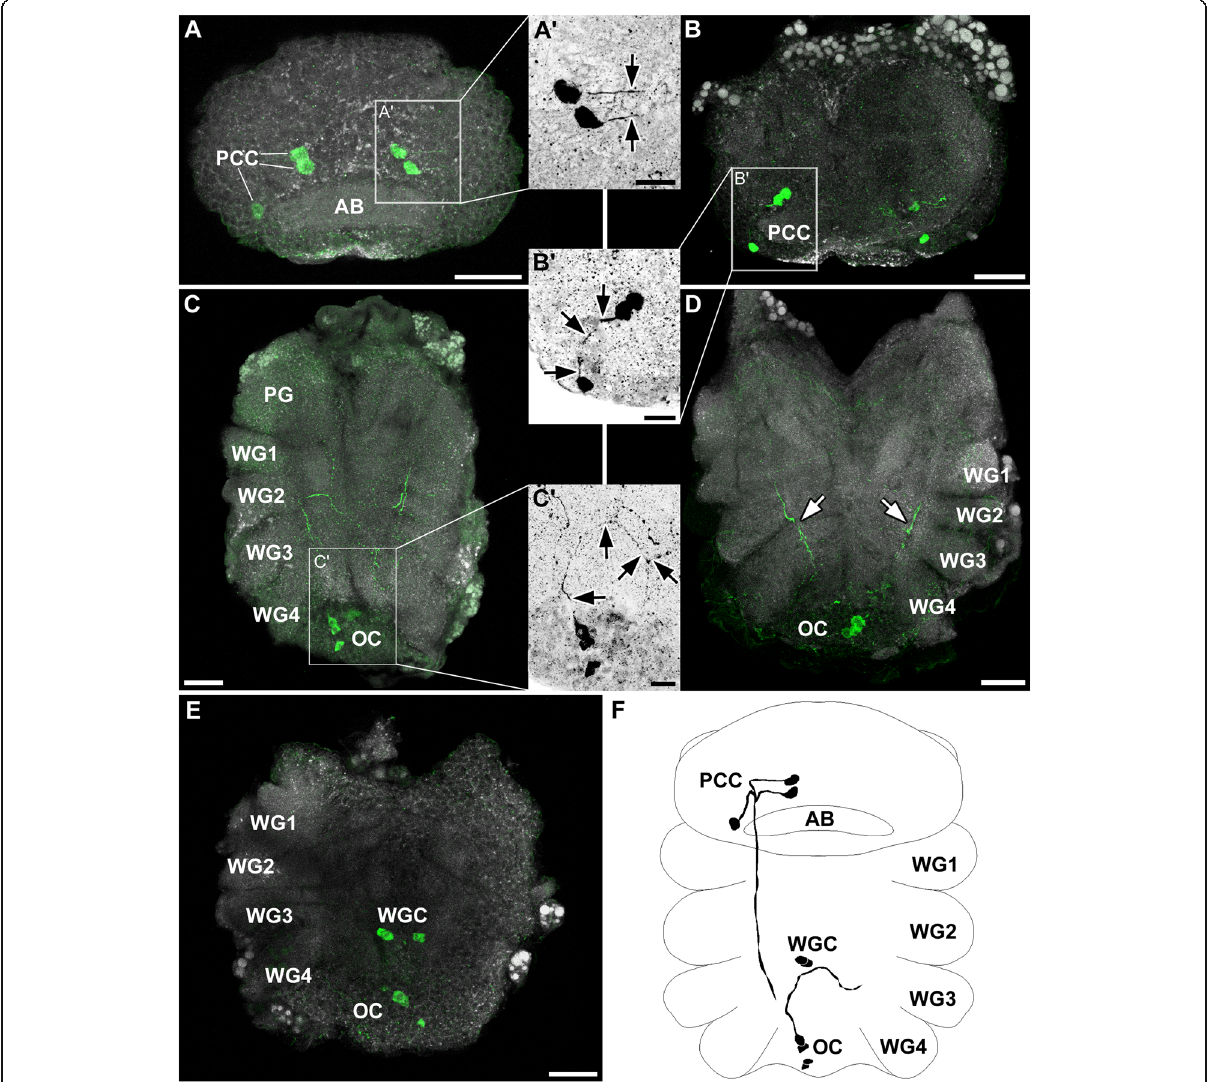
Fig. 7 Histaminergic neurons in the central nervous system of Chelifer cancroides . Maximum projections of cLSM stacks (ventral view, anterior to the top), showing immunoreactivity of histamine (green) and synapsin (grey). a, b Three protocerebral histaminergic neurons (PCC) per hemiganglion were identified in the protocerebrum: two PCC were positioned anterodorsally to the arcuate body (AB), one laterally to the AB. a ’ , b ’ All PCC projected single neurites toward each other (black arrows), before turning posteroventrally. c Two pairs of immunoreactive cell bodies (OC) were identified in the fused opisthosomal ganglia. c ’ A single contralateral projection arose from the OC (black arrows). d A conspicuous longitudinal immunoreactive tract projected throughout the length of the walking leg ganglia (white arrows). e A pair of histaminergic cell bodies (WGC) were found in the posterior regions of the prosoma, probably belonging to the walking leg ganglion 3. f Reconstruction drawings of selected histaminergic neurons in the central nervous system. Abbreviations: AB: arcuate body; OC: opisthosomal cell bodies; PCC: protocerebral cell bodies; PG: pedipalpal ganglion; WG1 – 4: walking leg ganglion 1 – 4; WGC: walking leg ganglion cell bodies. Scale bars: a – e: 50 μ m; a ’– c ’ : 25 μ